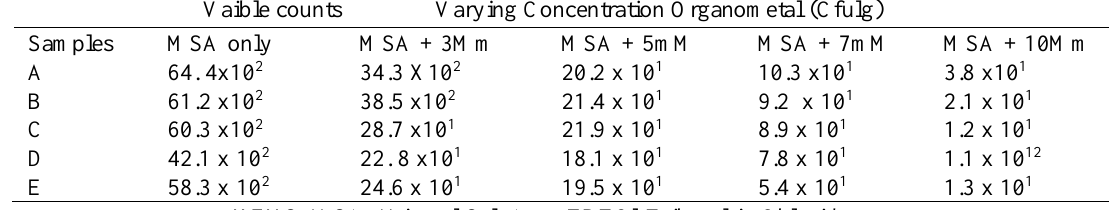
Figure 5: Acute toxicity of DPTCl on shrimps after 72 h exposure Table 3 Total Heterotrophic Counts in varying Concentrations of Organomatal Vaible counts Varying Concentration Organometal (Cfulg)